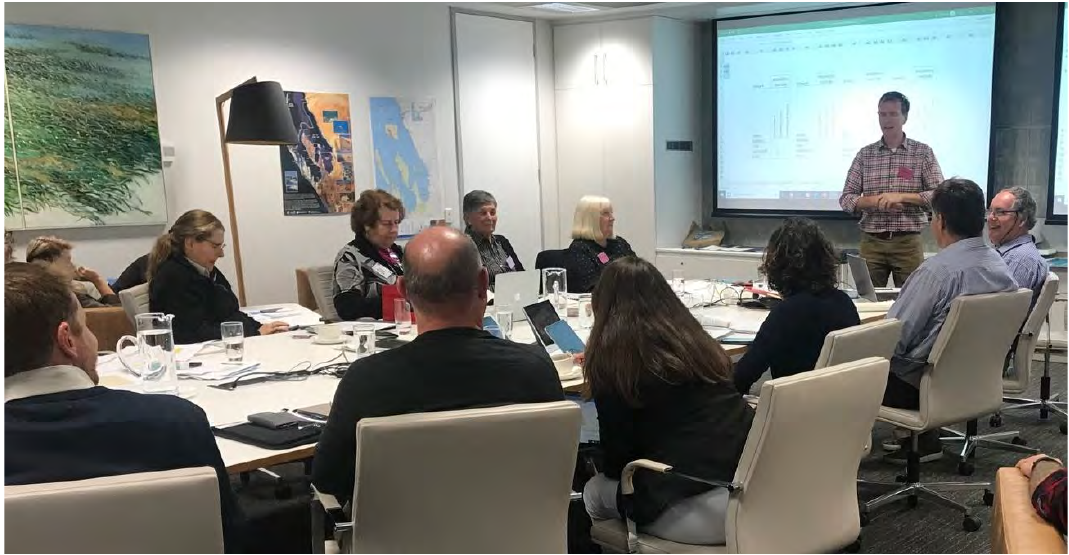
Figure 1.2 Undertaking the second phase of the CVI process during the June 2019 workshop in